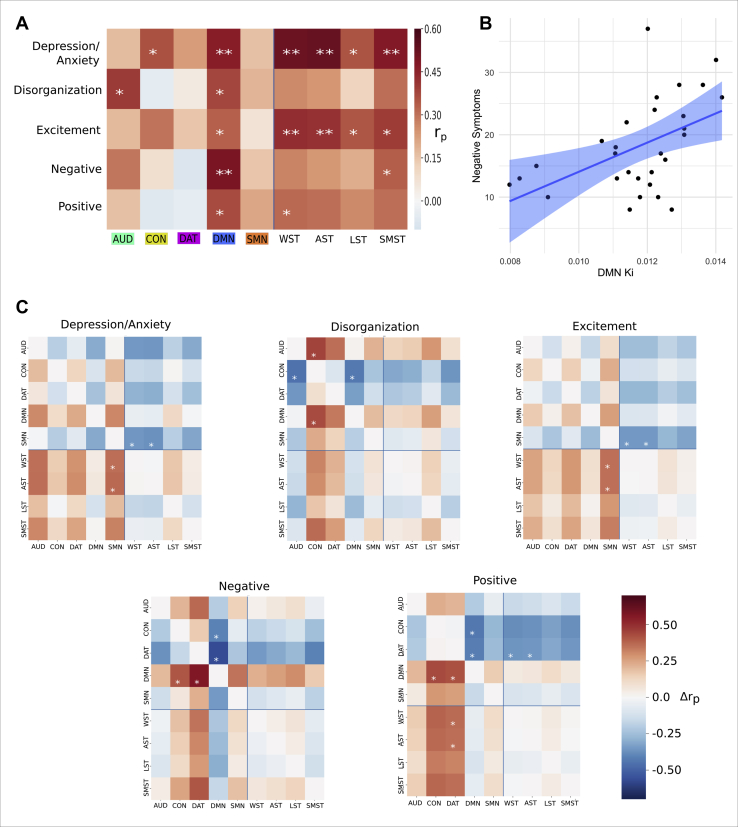
Relationships between dopamine synthesis capacity (Kicer) and psychotic symptoms. (A) Associations between Positive and Negative Syndrome Scale Marder factors and striatal Kicer (Ki) across different striatal subdivision regions. Heatmap displays rp values. Statistical significance calculated by permuting participants. ∗p < .05, ∗∗p < .05 (false discovery rate corrected). (B) The strongest association observed using the connectivity-based approach was between default mode network (DMN)–Kicer and the Marder negative factor score (rp = .49, p = .009). (C) Heatmaps illustrating the extent to which symptom-Kicer associations differ between subdivisions. Positive values indicate that the row subdivision shows a greater association with the Marder factor than the column subdivision. ∗p < .05. Connectivity-defined subdivisions: auditory network (AUD), cingulo-opercular network (CON), dorsal attention network (DAT), DMN, and sensorimotor network (SMN). Anatomically defined subdivisions: whole striatum (WST), associative striatum (WST), limbic striatum (LST), and sensorimotor striatum (SMST).